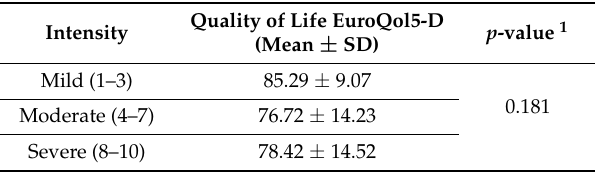
Table 3. Comparison of the mean total scores of quality of life in women, grouped according to the intensity of dysmenorrhea.